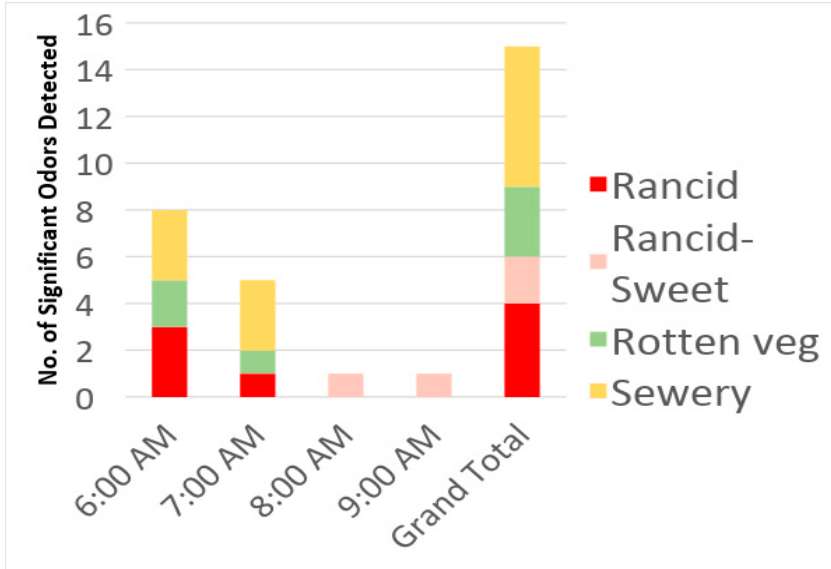
Figure 6. Hours of significant odors detected by the Odor Patrol. Note: if two different odors were detected at same time, it is considered two odor events.